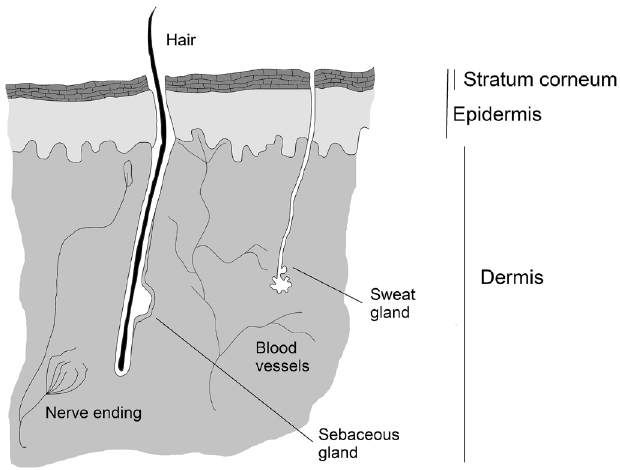
FIGURE 1 - Normal human